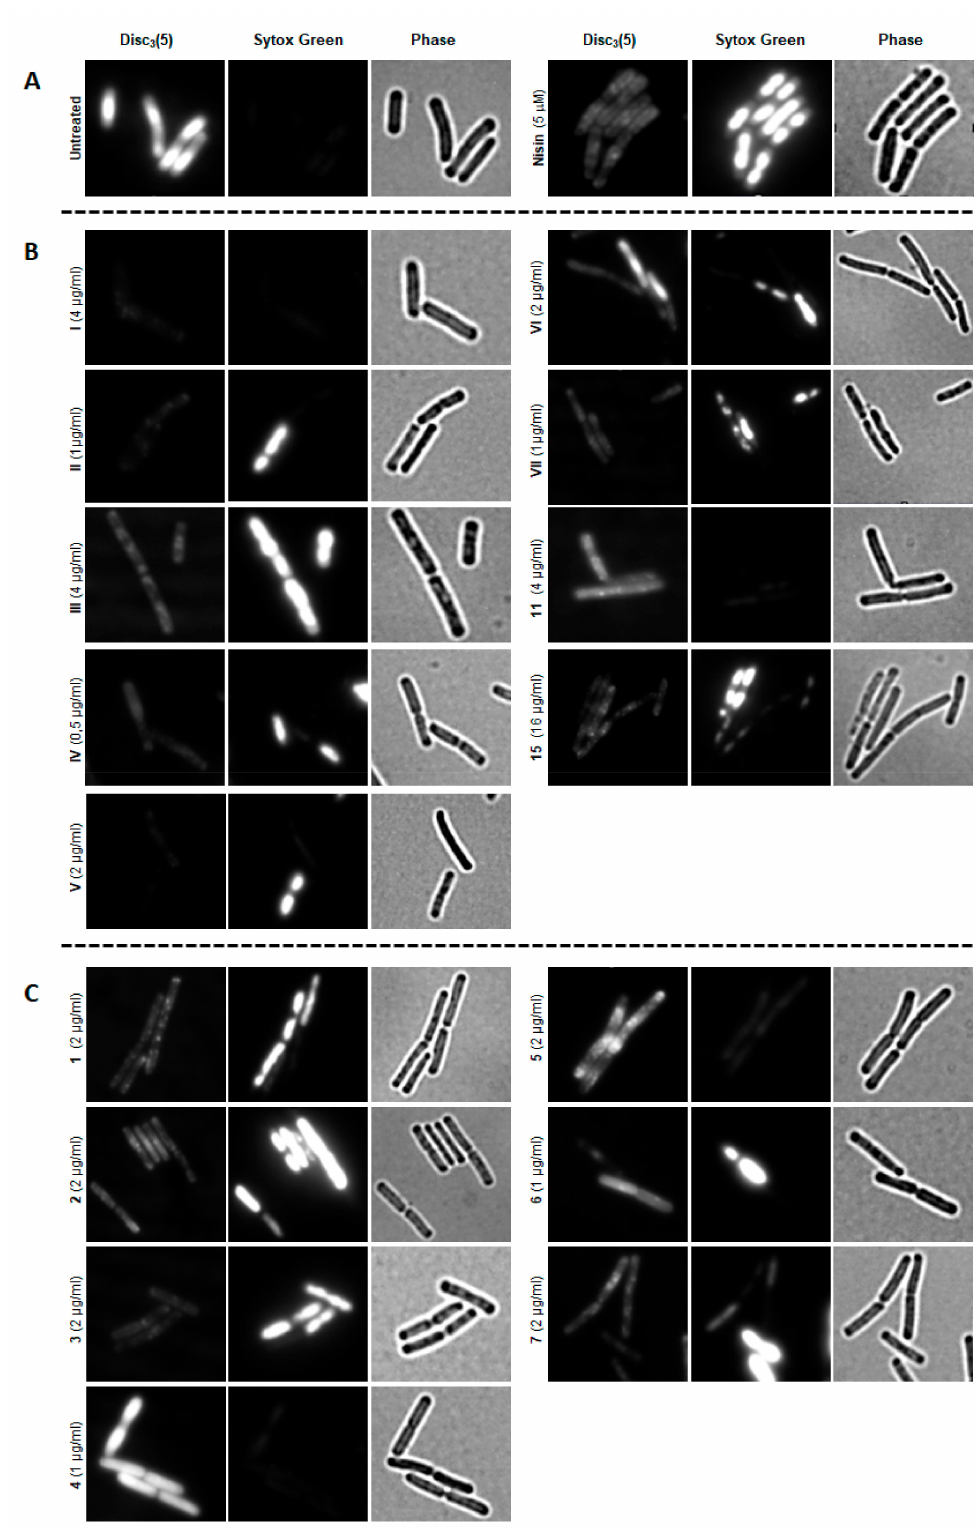
Figure 5. Selected microscopy images of cell membrane depolarization (Disc 3 (5)) and pore formation (Sytox Green) of B. subtilis WT168 in distilled sterile water (untreated) and in the presence of Nisin ( A ), in the presence of cationic dendritic systems ( I – VII , 11 , and 15 ) ( B ) and with their analogy containing Ag(I)-NHC ( 1 – 7 ) ( C ). Phase contrast images are also depicted. Incubation time 20